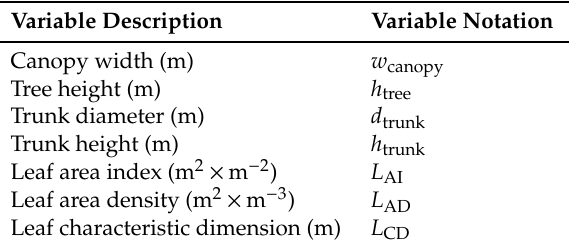
Table 1. Physical parameters associated with the canopy of a fruit orchard modelled by a parametric CTFD model. The leaf area index is the total one-sided leaf area per the ground area occupied by the plant, while the leaf area density is the total leaf area per plant-occupied volume. The leaf characteristic dimension is a equivalent circular area